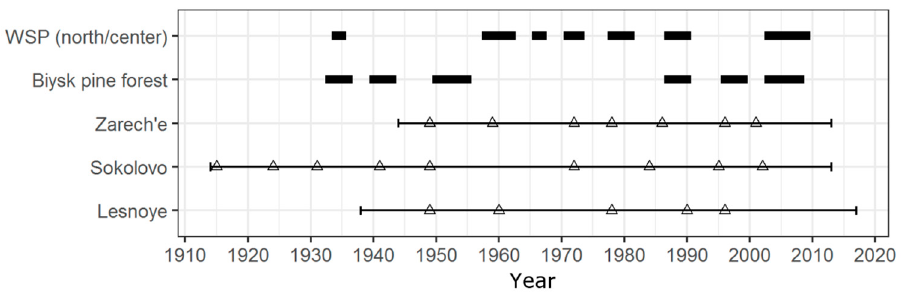
Figure 6. Documented pine looper outbreaks for the northern and central parts of the WSP (West Siberian Plain) forest-steppe [1,10,44], and Biysk pine forest [1,10] (black rectangles), and recon- structed (open triangles) ones. Horizontal lines show the period used for reconstruction.